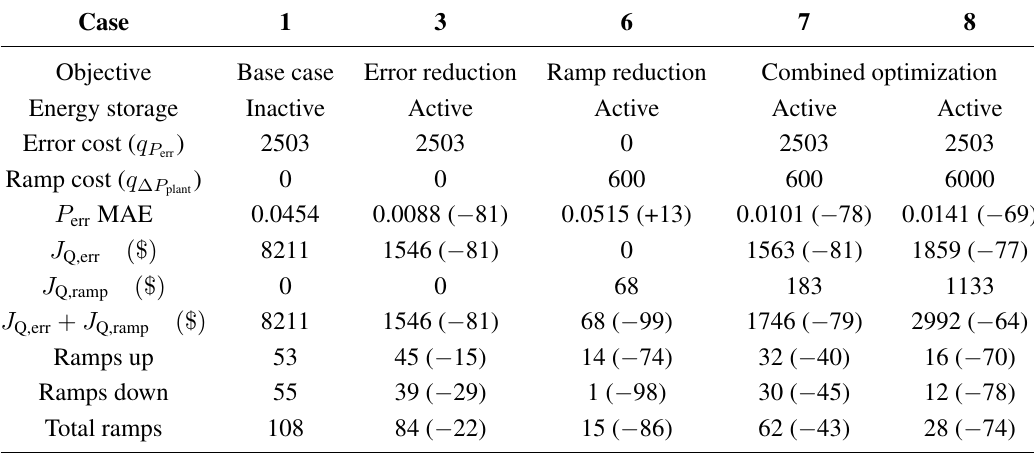
Table 2. Summary of error reduction, ramp reduction, and combined optimization cases over approximately one week (888 10-min samples). Percent change from the base case, Case 1, is given in parenthesis. Comparing Cases 7 and 8 with Case 3, it is shown that ramp events can be reduced with only a minimal impact on scheduling error. Compared with the base case, Case 1, it is shown that the scheduling error and the number of ramp events can be simultaneously